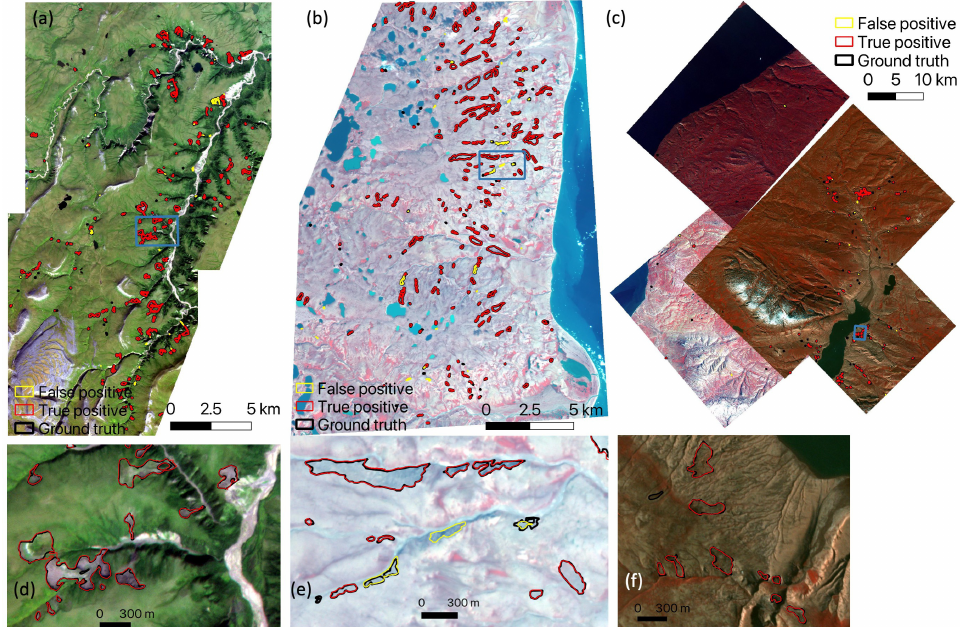
Figure 5. Mapped polygons in the three study areas. ( a – c ) are spatial distributions of mapped polygons for Willow River (WR), Jesse Moraine (JM), and Fosheim Peninsula (FP), respectively. ( d – f ) are enlargements of the regions in the blue rectangles in ( a – c ), respectively. The background of ( a , d ) are RGB images and others are nirGB images.